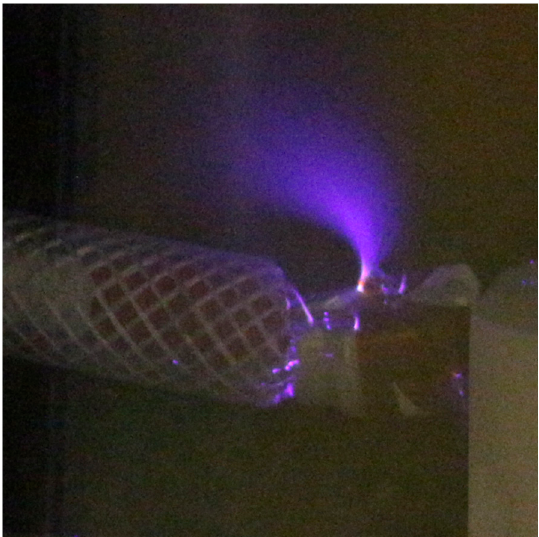
Figure A8. A 5-s exposure photograph of an experimental high voltage contact design which has not yet been optimized to reduce corona discharge. The source of the large corona discharge is a sharp edge of cut Kapton ® tape. This high voltage contact design was later replaced by the one described in the main text.